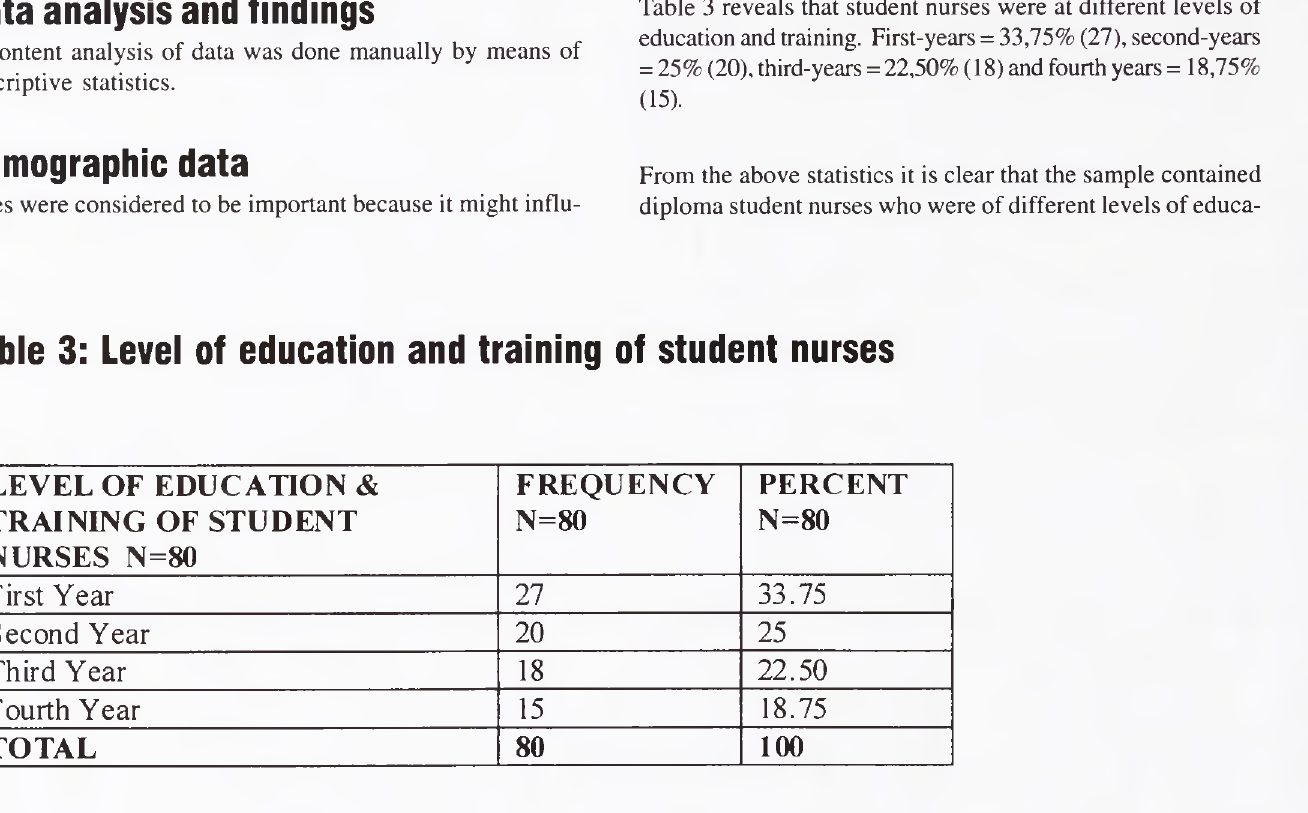
Table 3: Level of education and training of student nurses